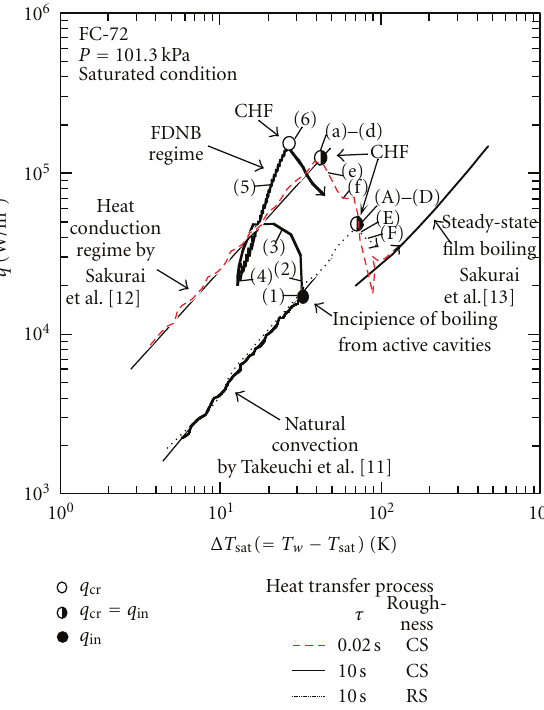
Figure 12: Boiling heat transfer processes from non-boiling to film boiling or FDNB at atmospheric pressure in saturated